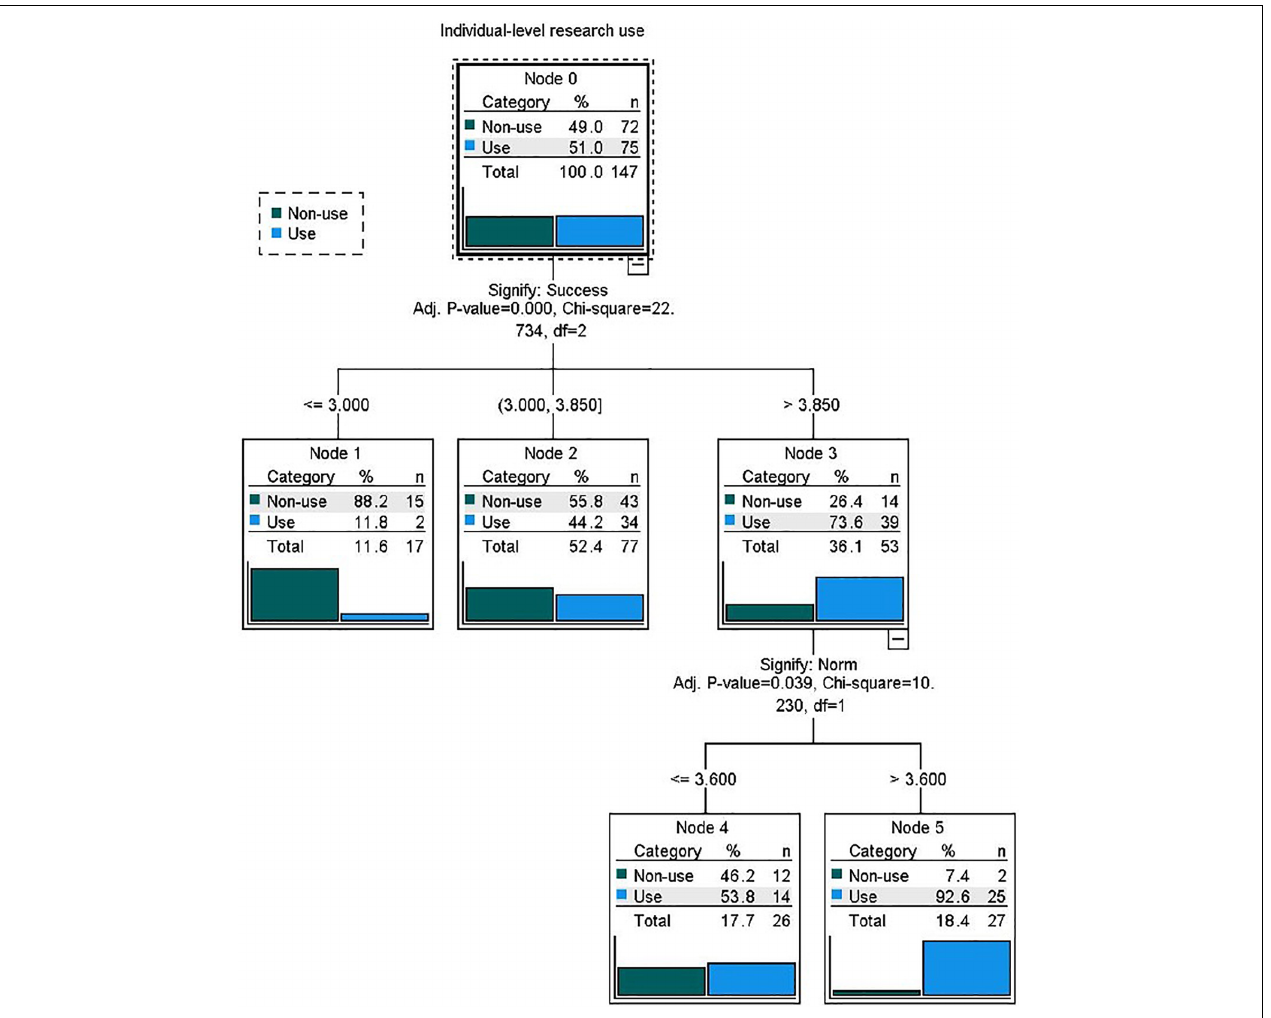
FIGURE 3 | Decision classification tree for the signification of research-use factors. Light gray shading within terminal nodes denotes the final